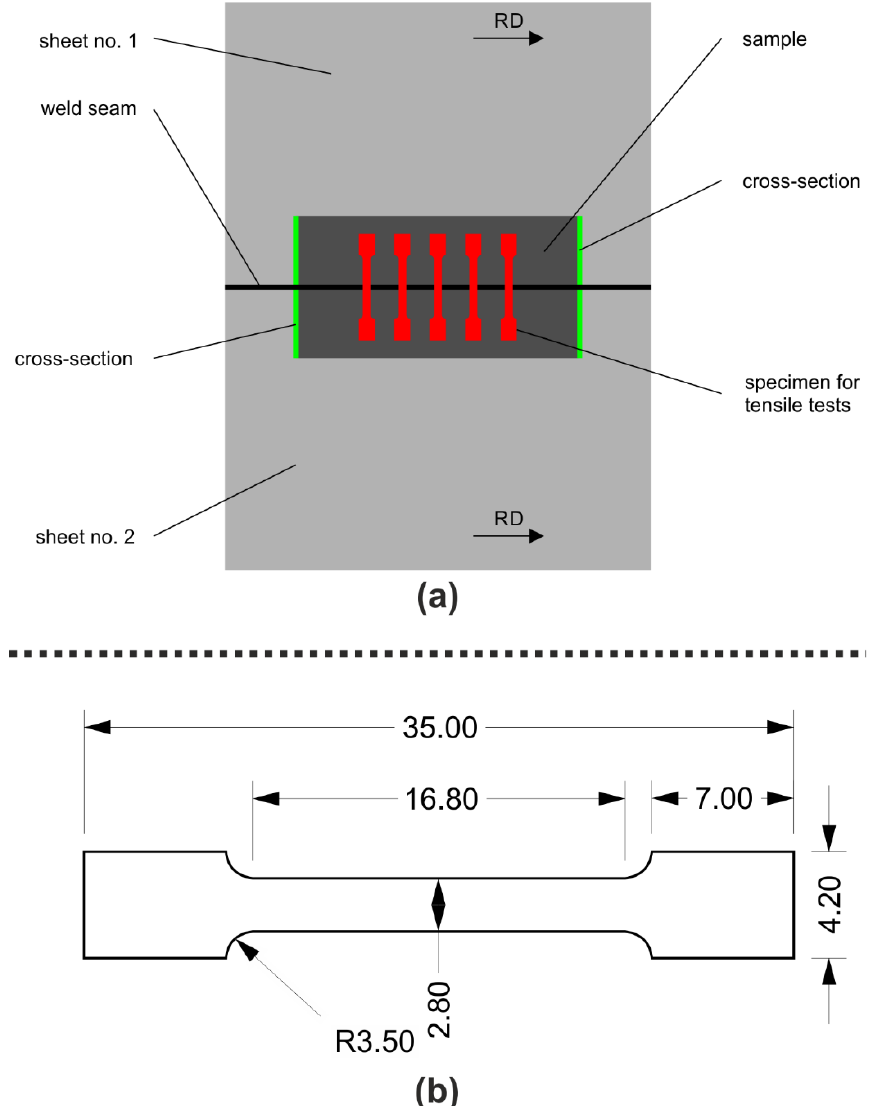
Figure 1. Schematic detailing ( a ) sample extraction location and ( b ) tensile testing geometry. adapted from [16] under CC-BY-license. All dimensions in